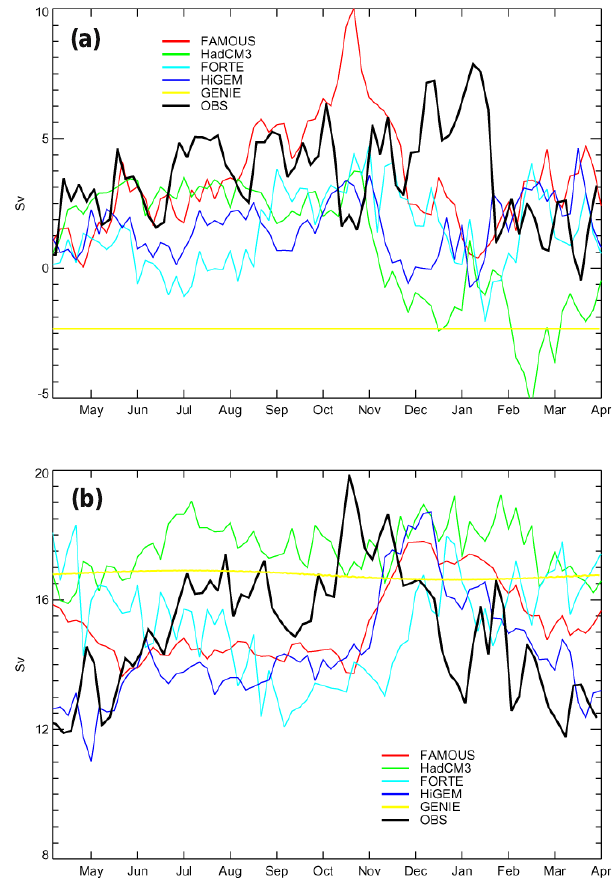
Fig. 5. Annual cycle of 5-daily Atlantic MOC ( T over ) components at about 29 ◦ N – (a) Ekman component ( T Ek ) and (b) Geostrophic component ( T geo